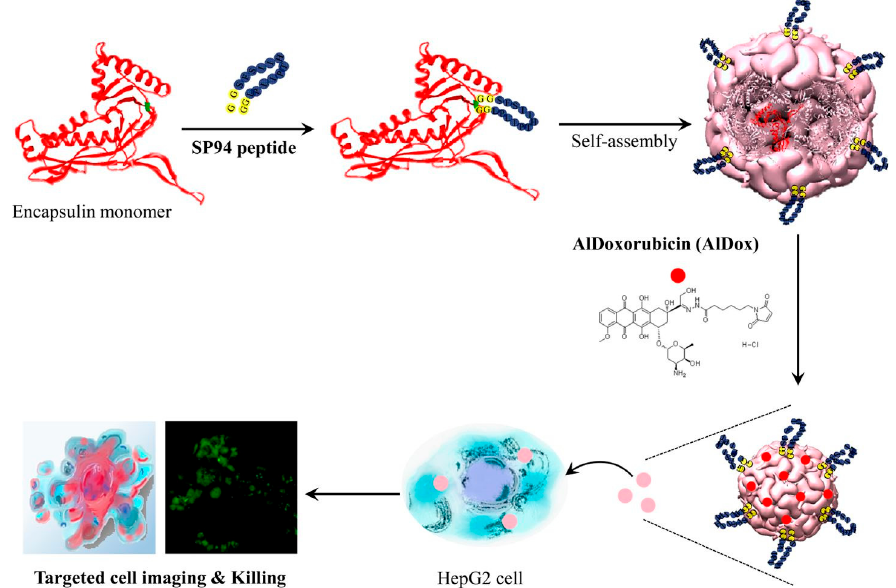
Figure 4. Scheme of encapsulin-based targeted drug delivery to hepatocellular carcinoma cells. Reprinted with permission from [74]. Copyright 2014, American Chemical Society.